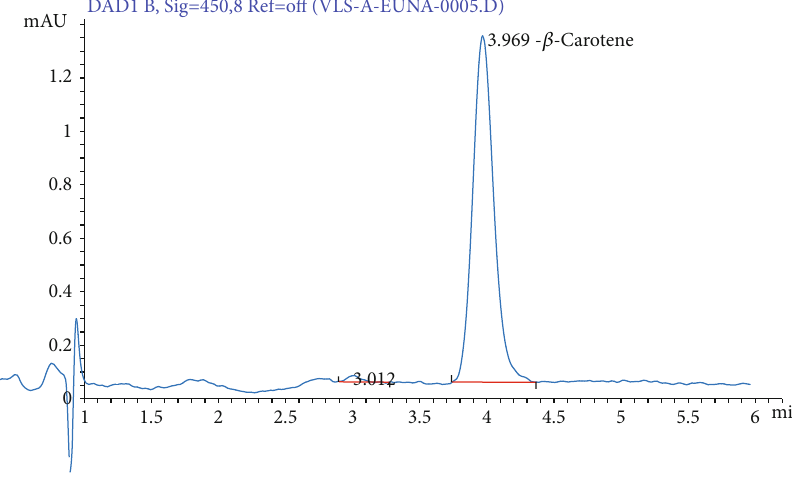
Figure 2: Sample HPLC chromatogram of β -carotene at